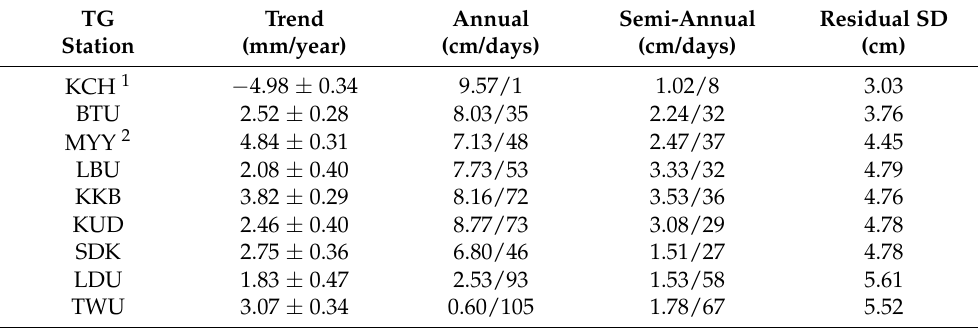
Table 3. TG results for Sabah and Sarawak (East Malaysia). No trend split was needed. For the periodic cycles, the amplitude and phase are given where the latter is transformed to days after 1 January. The residual sigma is the std of the difference between data and model fit. Trend uncertainties are given at a 95% confidence level (1.96 sigma). TG Trend Station